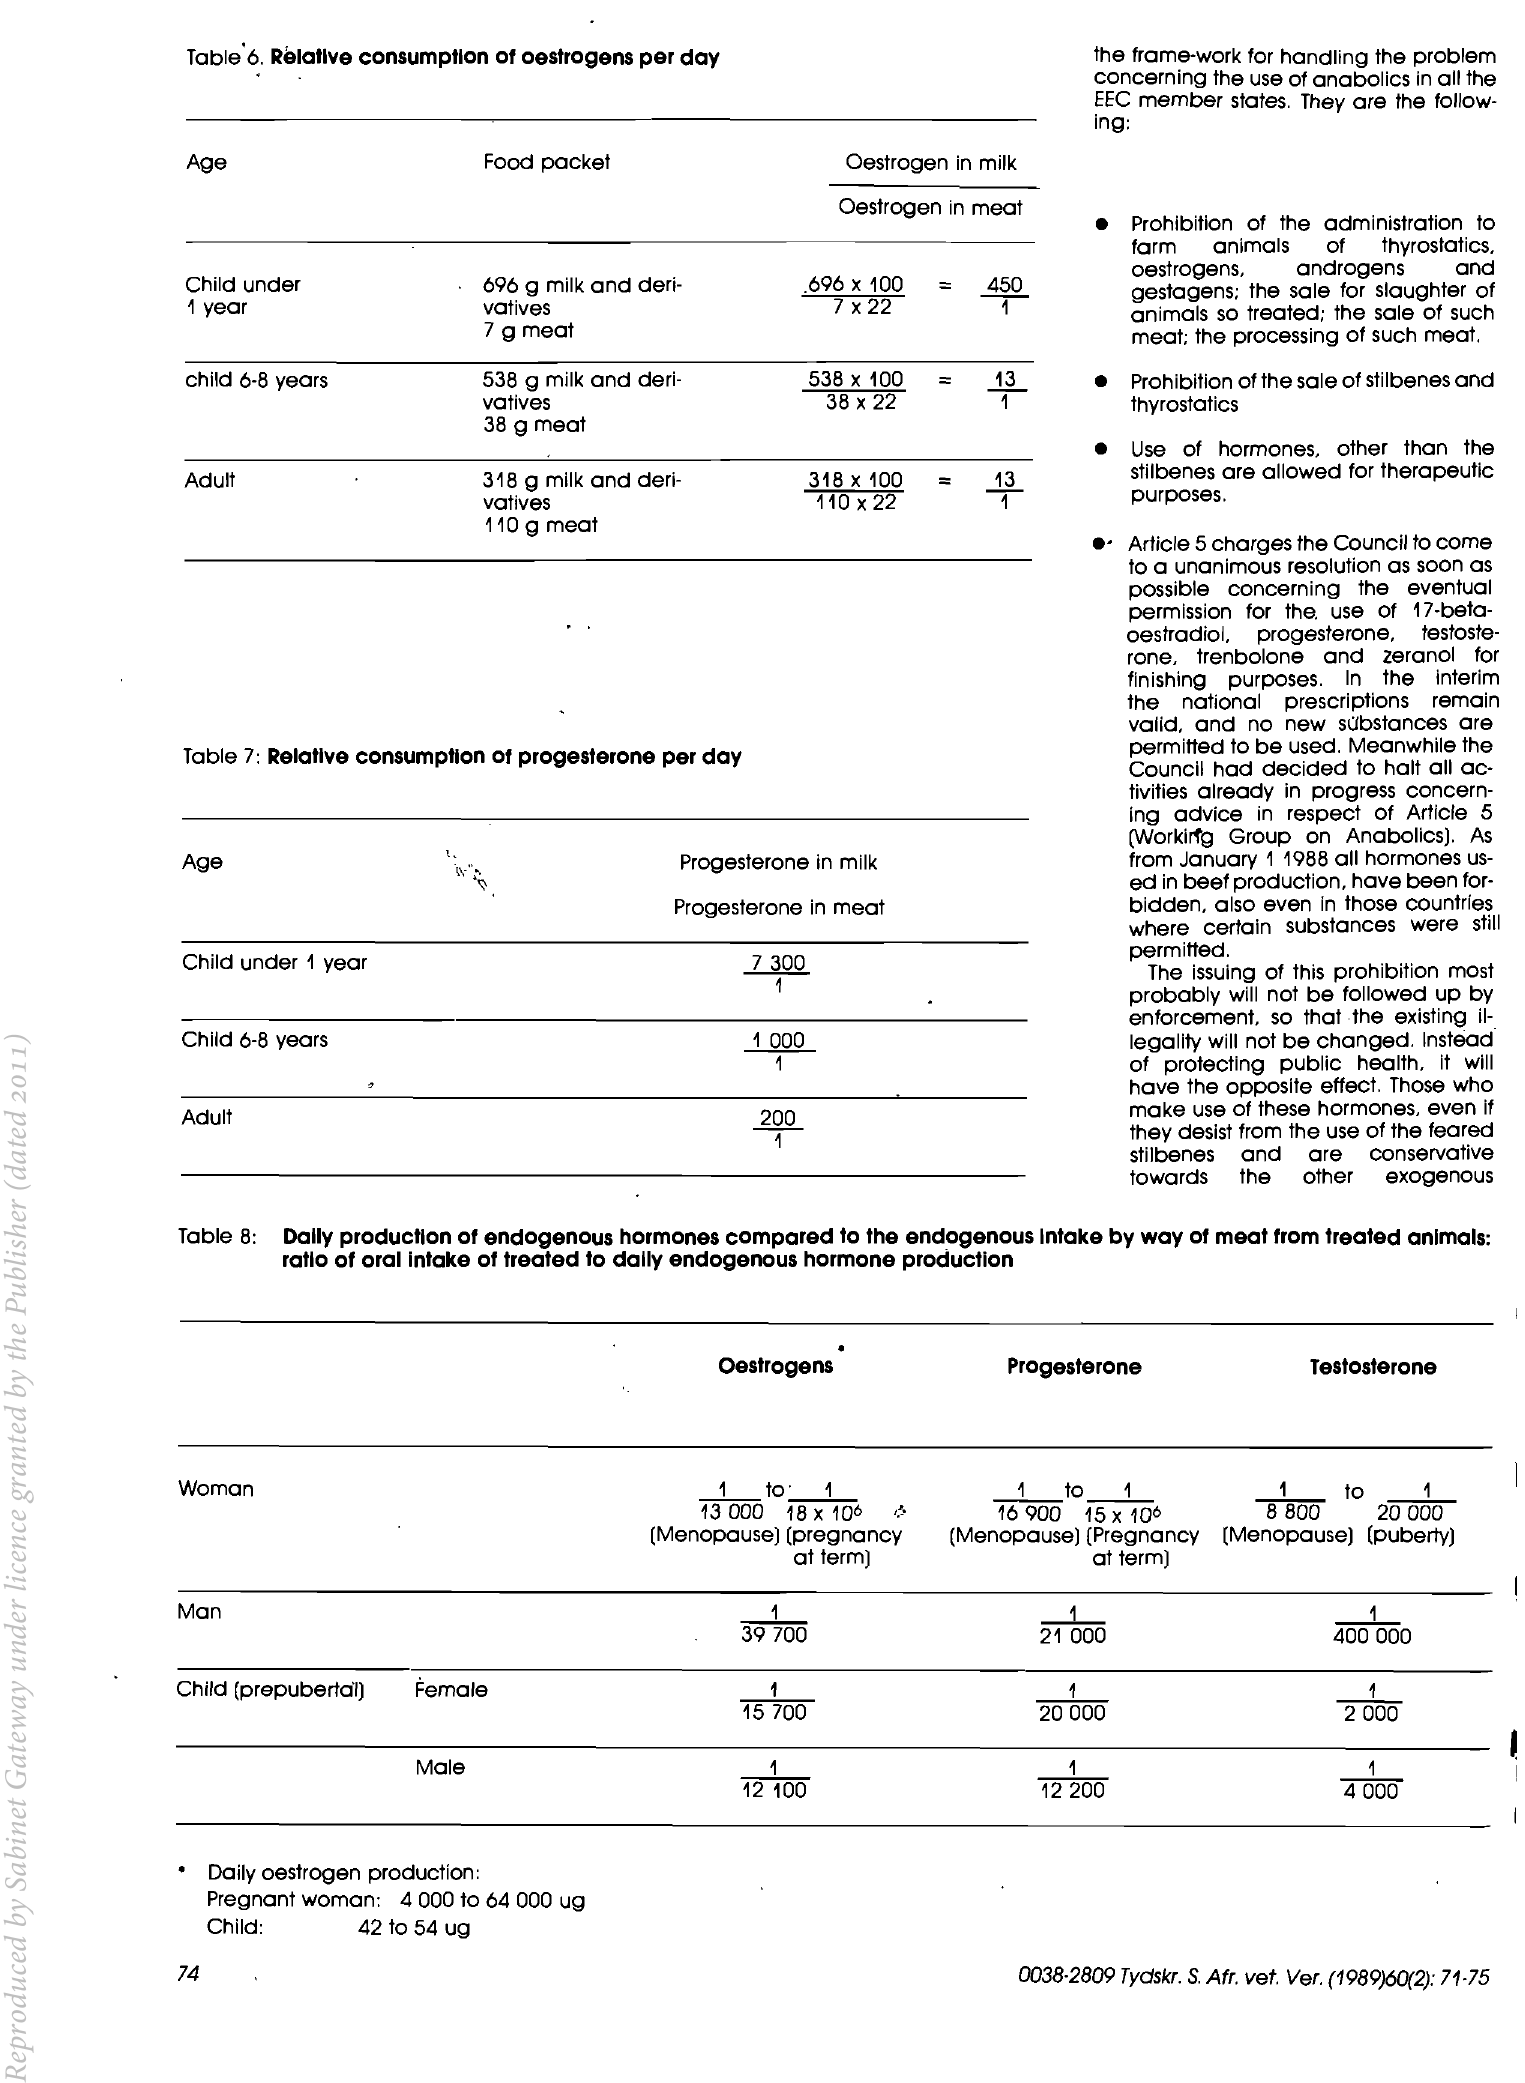
Table'6. Relative consumption of oestrogens per day